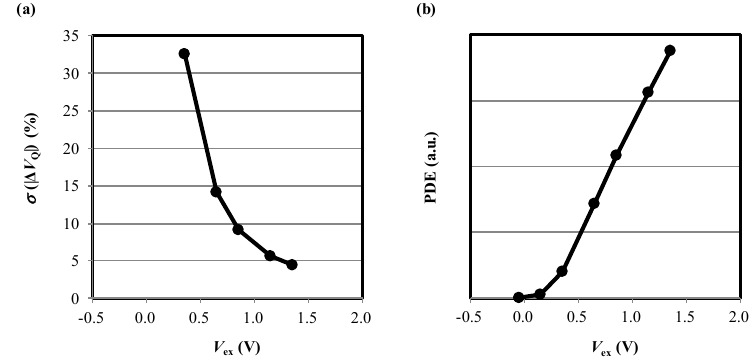
(cid:12) (cid:12) (cid:12) (cid:12) (cid:12) ∆ V Q (cid:12) . ( b ) Photon detection e ffi cient